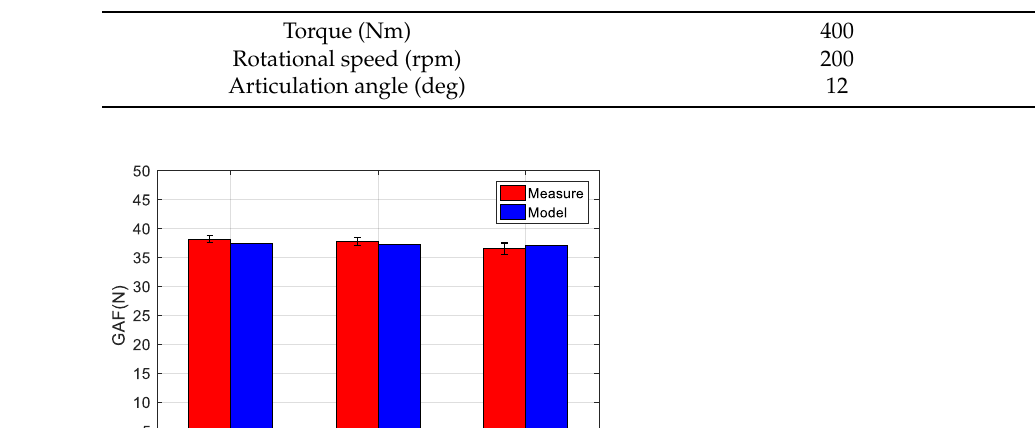
Table 2. GAF verification conditions.